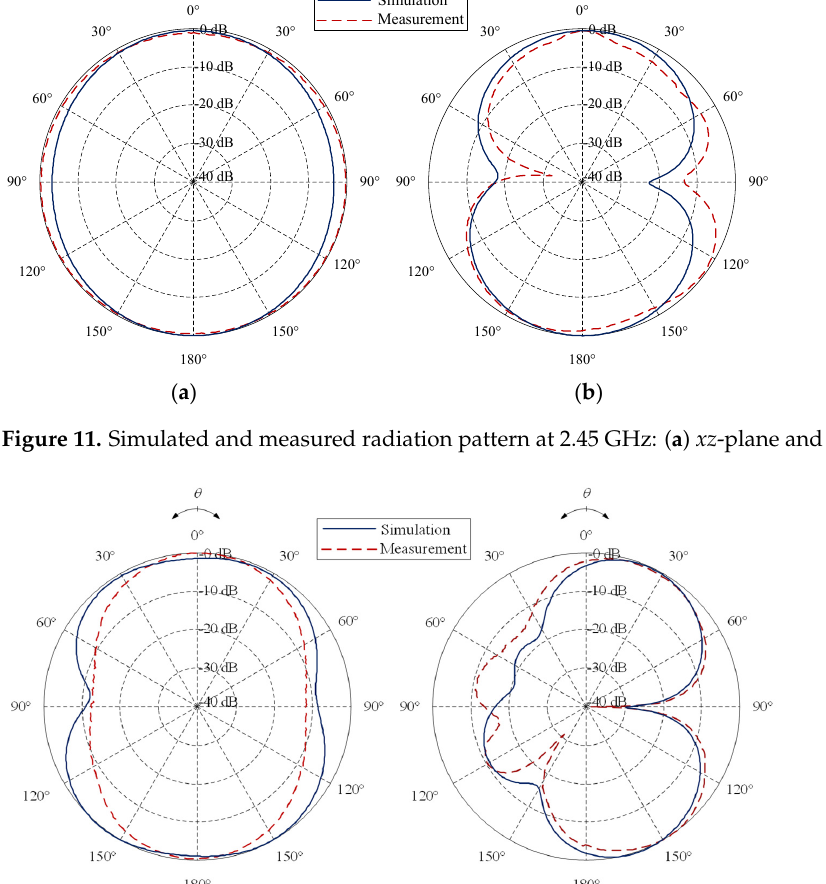
Figure 12. Simulated and measured radiation pattern at 5.5 GHz: ( a ) xz -plane and ( b ) yz -plane.